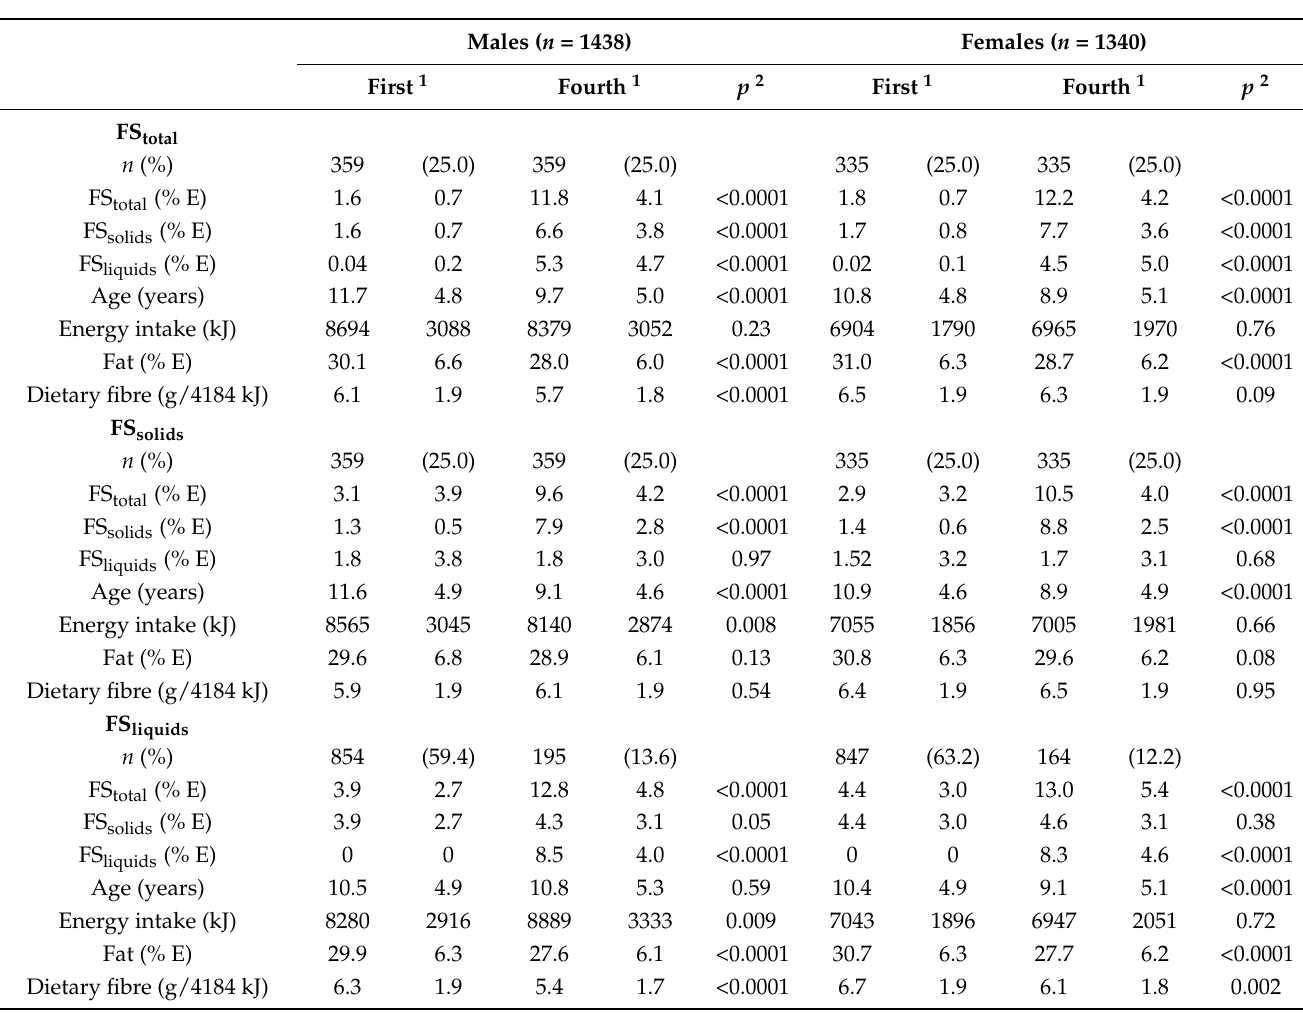
Table 2. Basic characteristics of Japanese children and adolescents aged 2–19 years according to free sugars intake: the 2016 National Health and Nutrition Survey,